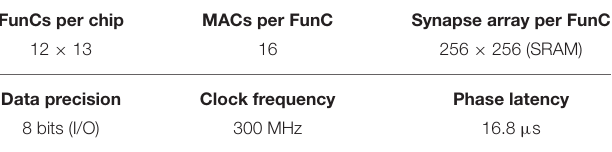
TABLE 2 | Chip configuration. TABLE 3 | Information about the five video workloads.